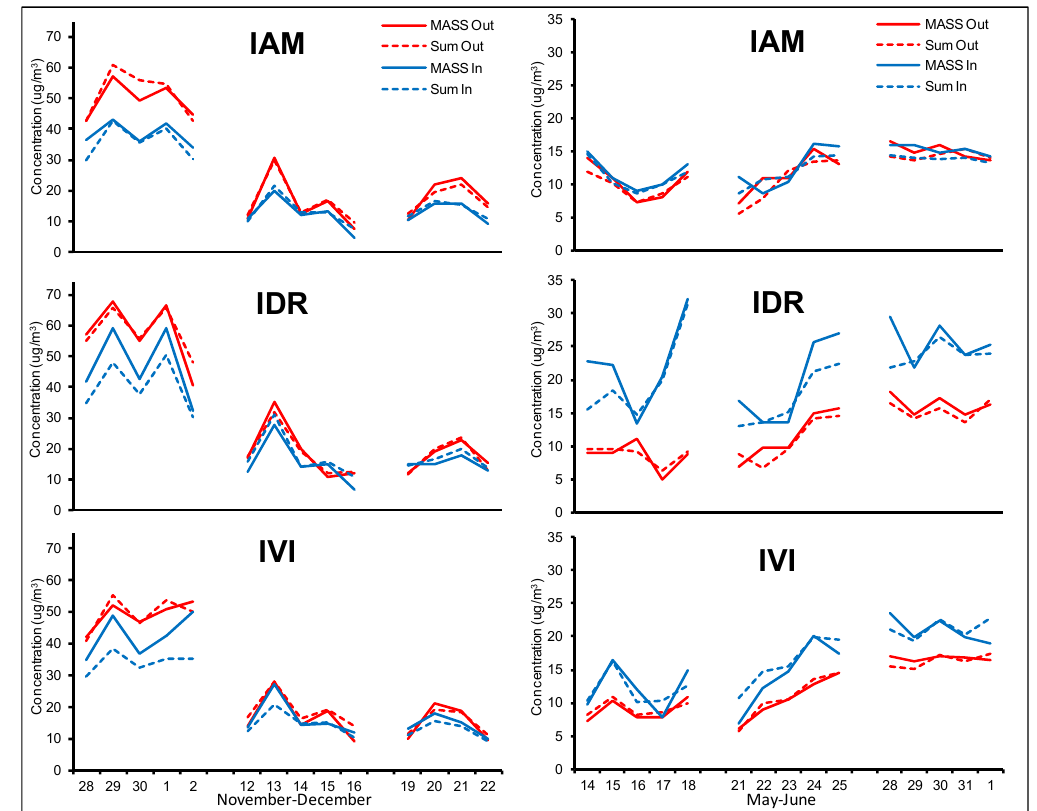
Figure 2. PM 2.5 concentration measured outdoor (red lines) and indoor (blue lines) measured by gravimetry (solid lines) and reconstructed from chemical analyses (dotted